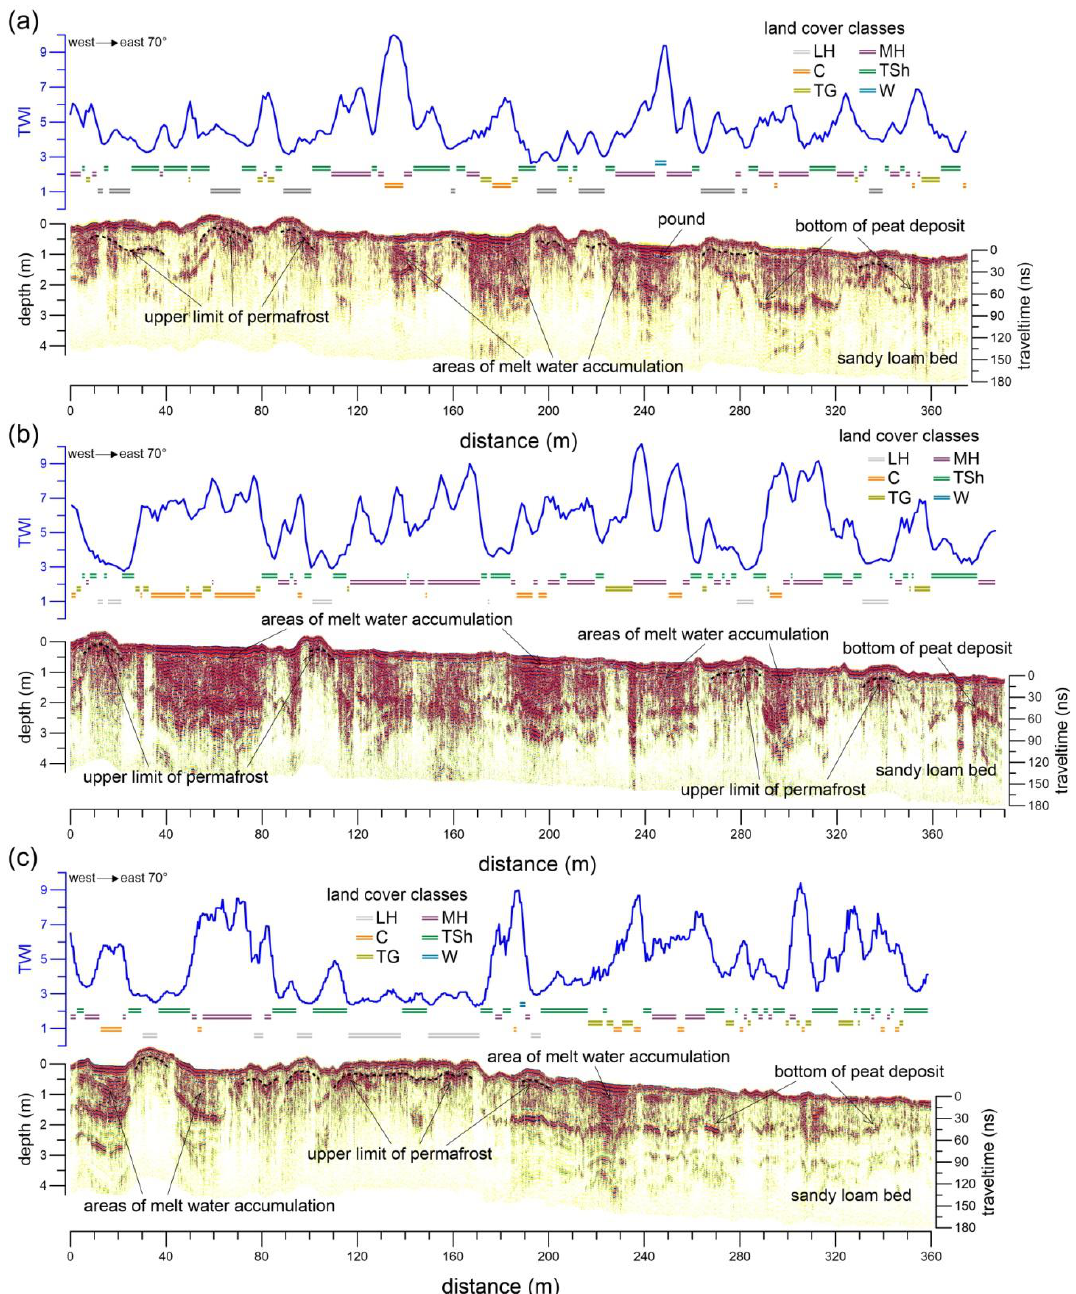
Figure 8. GPR cross-section, graph of TWI and LCC intervals from profiles GPR 1 ( a ), GPR 2 ( b ), and GPR 3 ( c ); dashed lines delineate permafrost table.